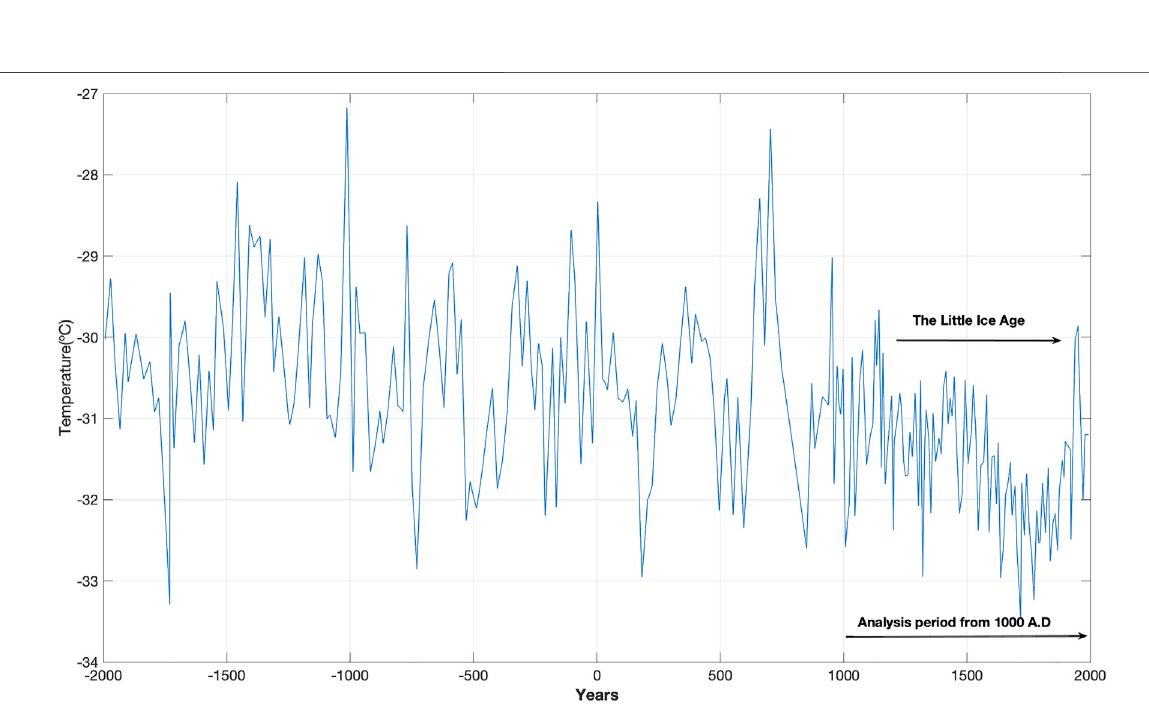
Frontiers in Astronomy and Space Sciences | www.frontiersin.org May 2022 | Volume 9 | Article 839794